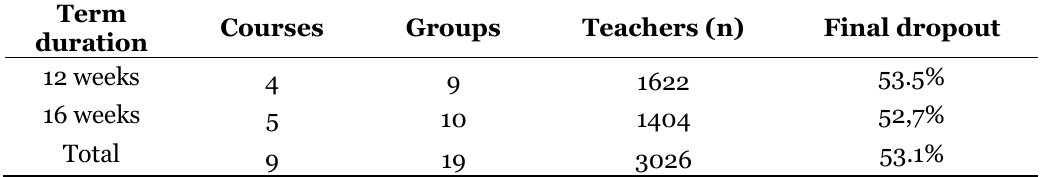
Sample Composition and Dropout Rates in 12 and 16 Weeks’